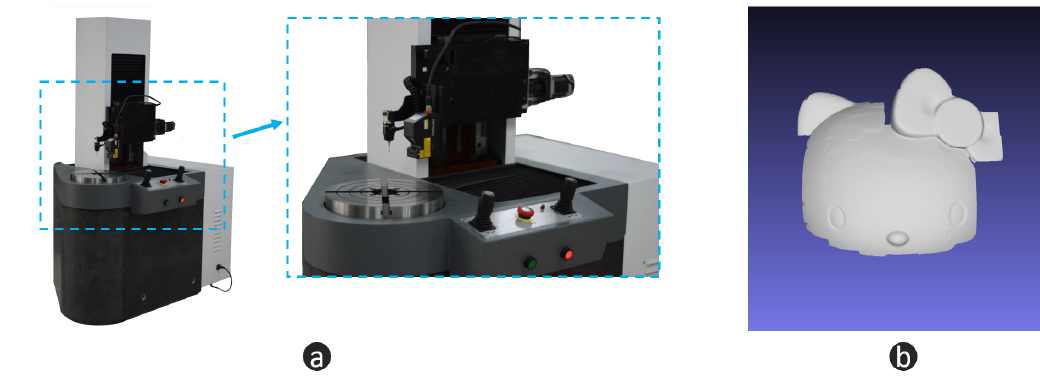
Figure 11. Ground truth data. ( a ) high accuracy 3D measurement equipment, resolution = ± 5 µ m; ( b ) high accuracy ground truth measurement